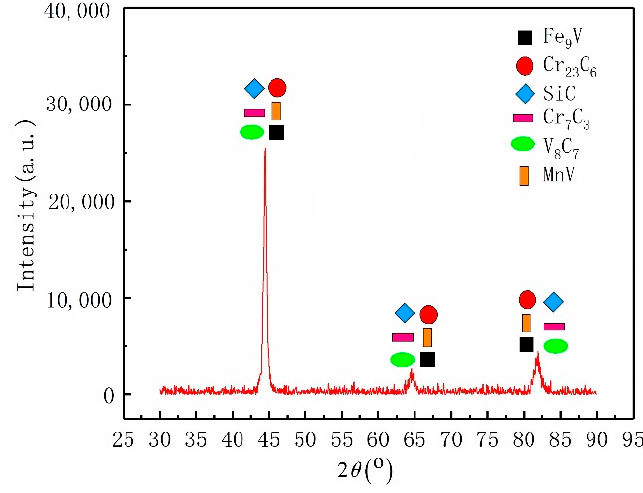
Figure 7. XRD profile of surfacing layer.